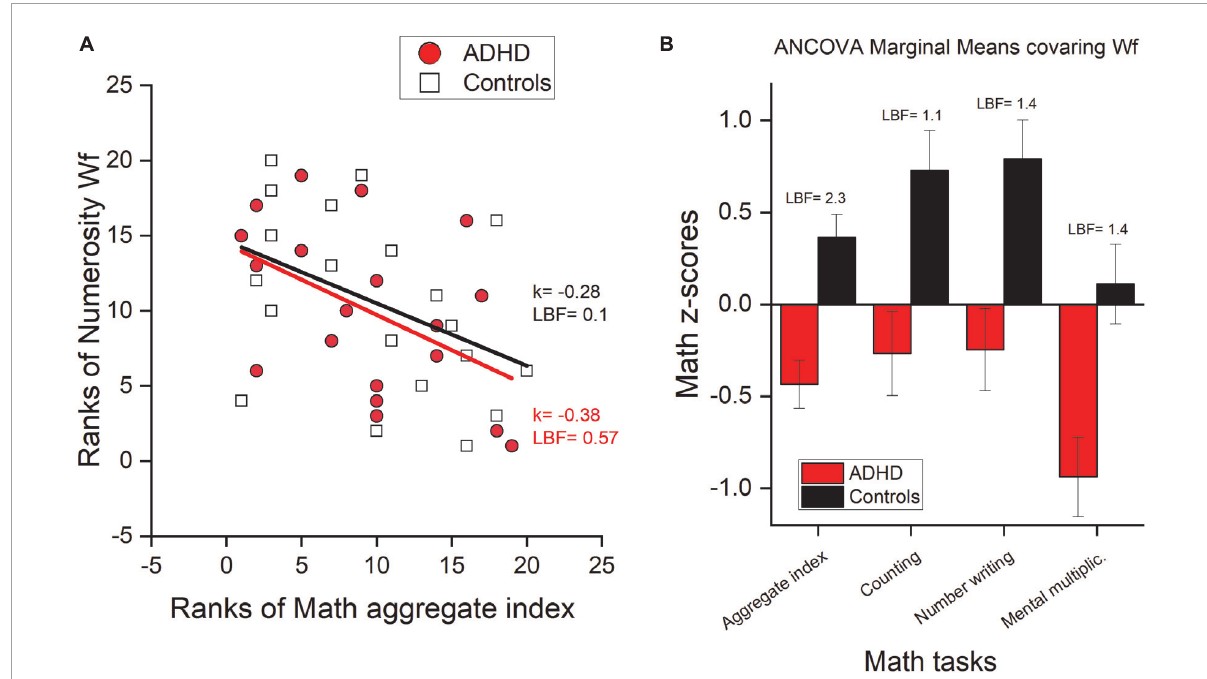
FIGURE6 Mathematical abilities and numerosity perception. (A) Kendall rank correlation between numerosity precision (Wf) and math abilities (aggregate index). (B) ANCOVA marginal means of math z -scores obtained after having regressed out numerosity precision (Wf). Error bars report ± 1 s.e.m.